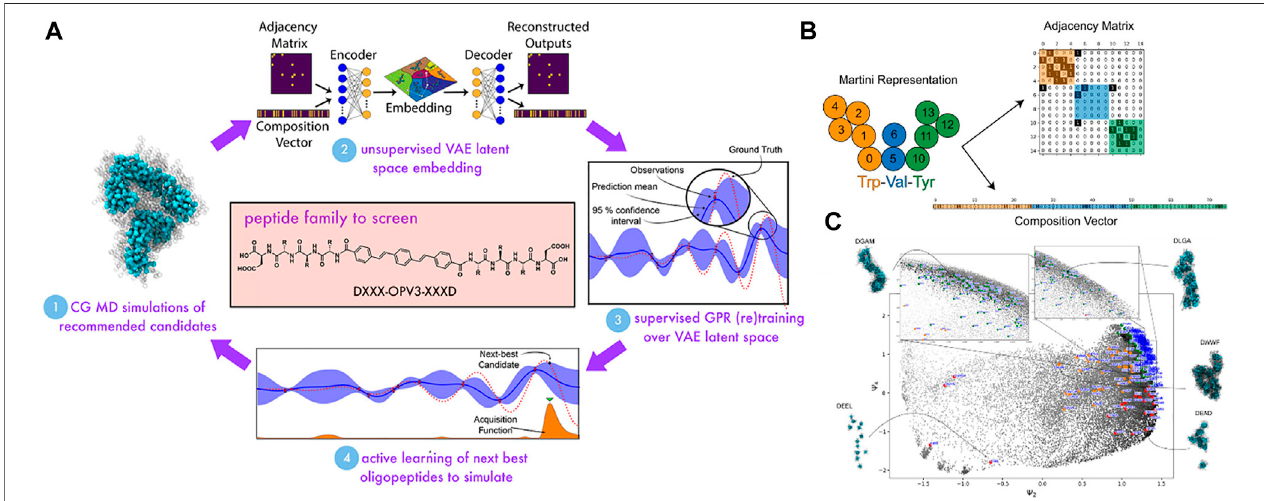
FIGURE 9 | Target design of self-assembling π -conjugated peptides using active learning algorithm. (A) Scheme of active learning approach (Bayesian optimization) in search of DXXX-OPV3-XXXD peptides with optimally self-assembling behaviors: (1) CGMD simulations are performed on 90 randomly selected candidates ofthe family and their self-assembling abilities are measured based on fi tness function f; (2) The self-assembled aggregates from high-dimensional chemical spaceareprojectedintoalow-dimensionalitymanifold(latentspace)usingavariationalautoencoder(VAE).Thedimensionalityofthelatentspaceisoptimizedafter each cycle via minimizing the VAE loss function; (3) A Gaussian process regression (GPR) model establishes a relationship between the latent space coordinates of peptides and their fi tness function f which indicates the self-assembled property of peptides. The GPR model improves every cycle (with an additional training point); (4) An acquisition function is used to predict the “ next-best ” DXXX-OPV3-XXXD candidates for which to run CGMD simulations to direct sampling toward the most promising candidates. The active learning loop is cycled until the GPR surrogate model has no more updates with the additional training data points. Eventually, the top candidates predicted from the active learning will be validated using explicit MD simulations. (B) The representation of each XXX tripeptide (e.g., Trp-Val-Tyr) to the VAE includesanadjacencymatrix A i indicatingtheconnectivityofMartinibeadswithinthetripeptideandaone-hotencodedcompositionvector T i representingtheidentityof thebeads.Thecouple (A i , T i ) isthenusedastheinputoftheVAEembedding. (C) Snapshotsareharvestedfromallmolecularsimulations(558,000intotal)projectedinto the ψ 2 - ψ 4 plane (top three nontrivial diffusion map eigenvectors). The result showcases natural categorization for self-assembling behaviors represented by colored points (green for good assemblers, red for intermediate assemblers, and orange for poor assemblers), which demonstrates design rules to promote good assembly behaviors. Figure was reproduced from Ref. (Shmilovich et al., 2020) with